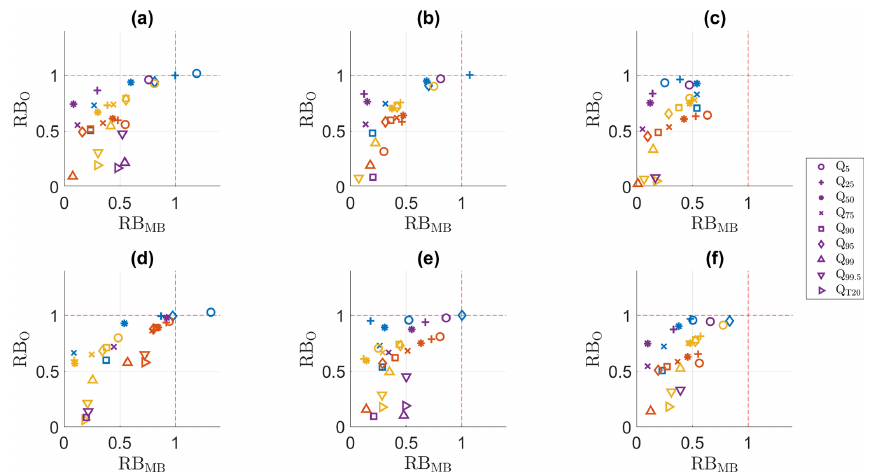
Figure 11. RB MB versus RB 0 for the discharge percentiles and the 20-year return period value in the validation period. (a) QDM, (b) mQDM, (c) MBCn, (d) MRQNBC, (e) dOTC, (f) R 2 D 2 . Winter: blue, spring: ochre, summer: yellow, autumn: